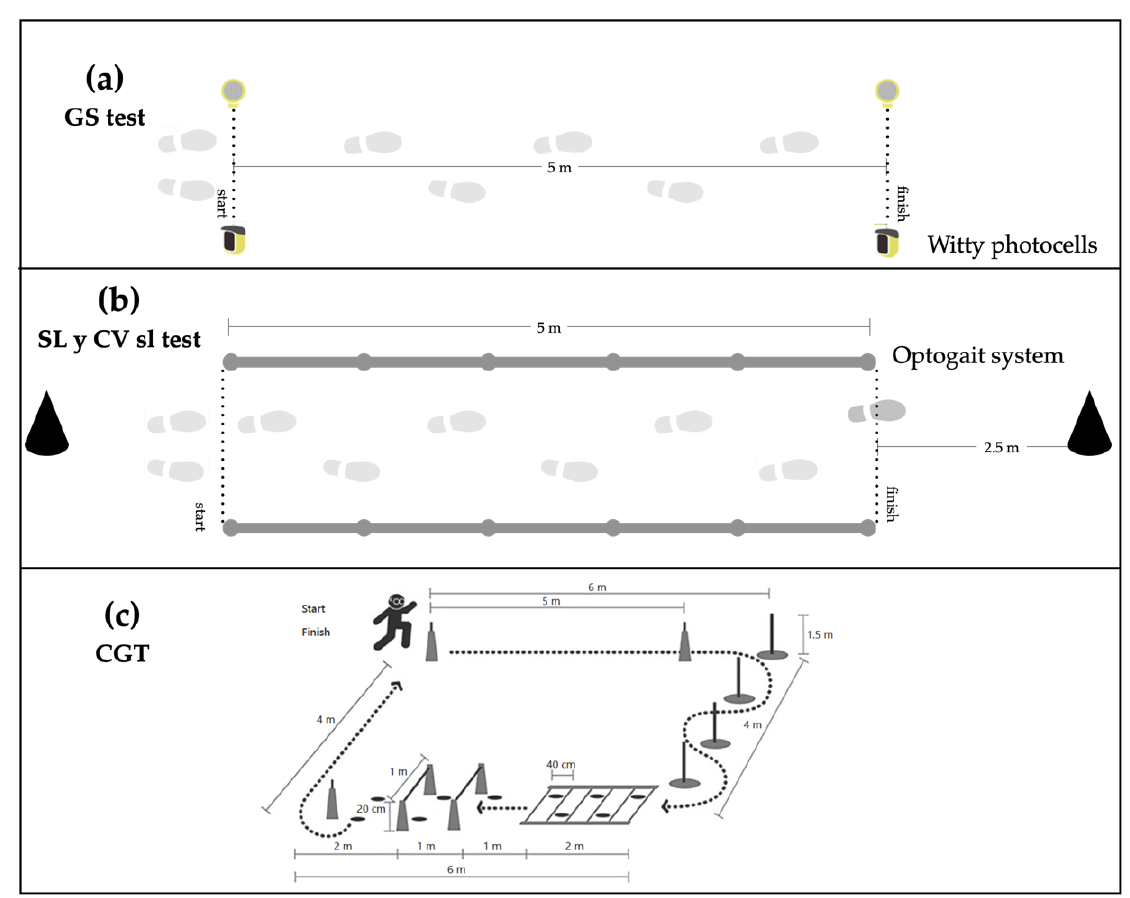
Figure 1. Assessment tests of gait performance variables. ( a ) Gait speed (GS), ( b ) stride length (SL) and gait variability (CV sl), and ( c ) complex gait test (CGT).